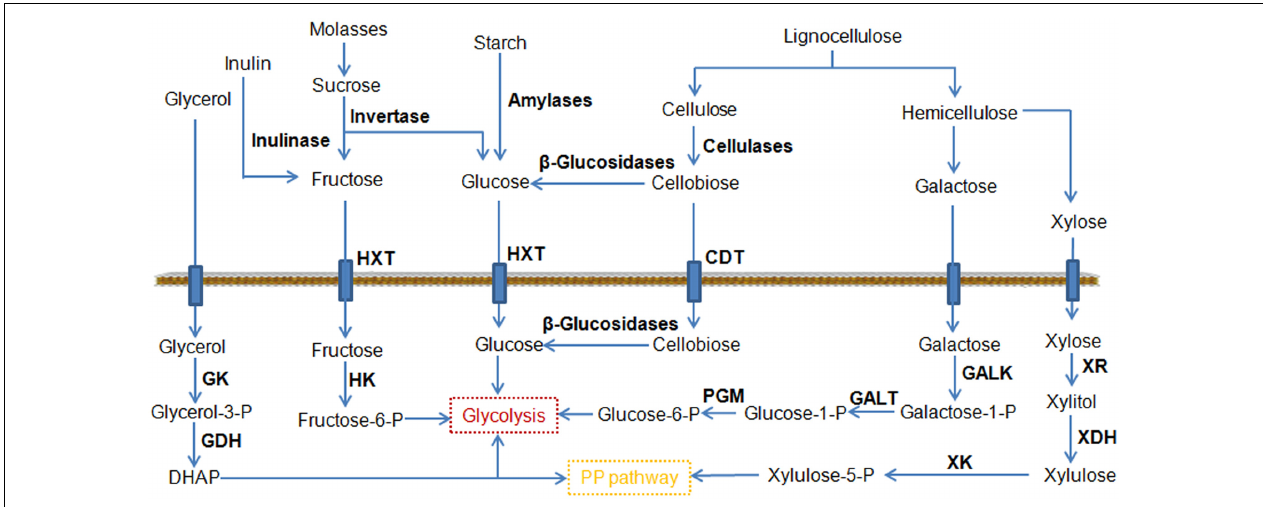
FIGURE 3 | Schematic representation of the pathways leading to the consumption of an expanded range of substrates by metabolic engineering. CDT, cellodextrin transporter; GALK, galactokinase; GALT, galactose-1-phosphate uridylyltransferase; GDH, glycerol-3P dehydrogenase; GK, glycerol kinase; HK, hexokinase; HXT, hexose transporter; PGM, phosphoglucomutase; XDH, xylitol dehydrogenase; XK, xylulokinase; XR, xylose reductase.